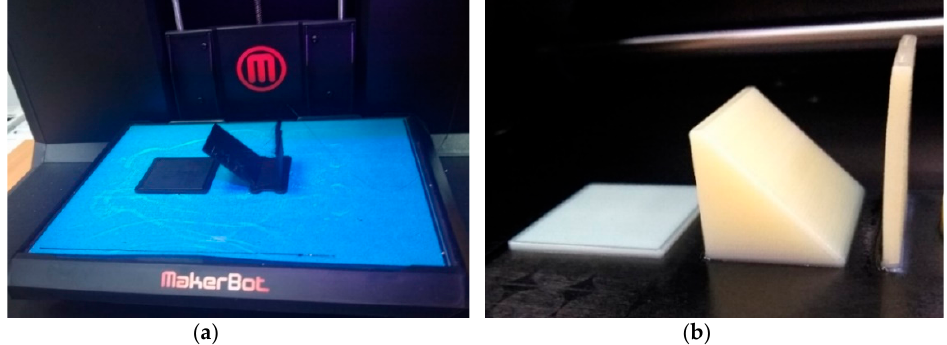
Figure 5. Overview of 3D printed samples: ( a ) 3D printed samples prepared from PLA by FFF technology and ( b ) from MED610 by PJM technology.